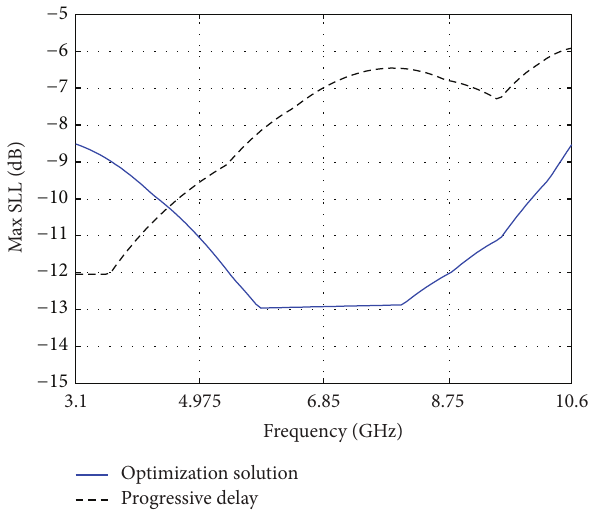
Figure 7: Comparison of the beamwidth of the power pattern in each frequency in the UWB spectrum for the optimized solution and the conventional